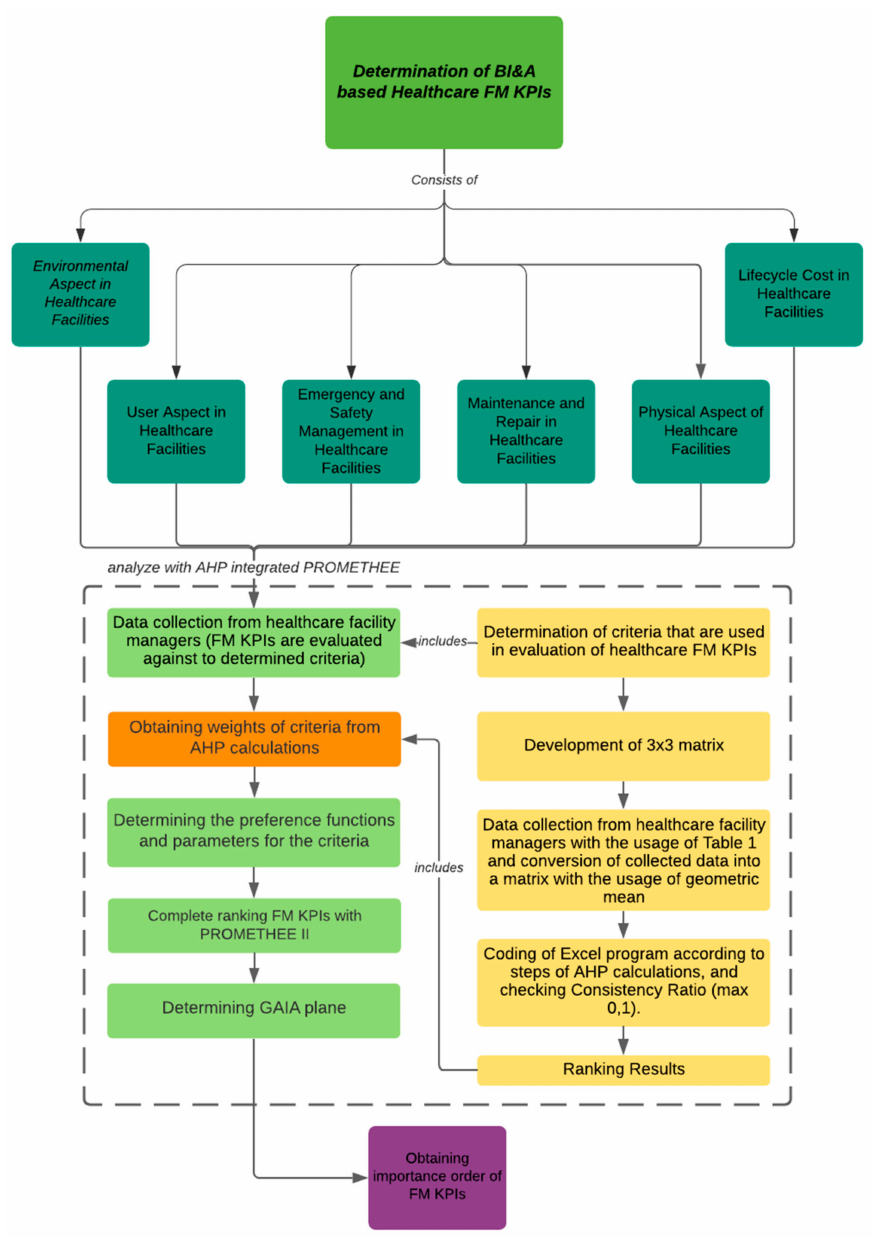
Figure 1. The concept map of the